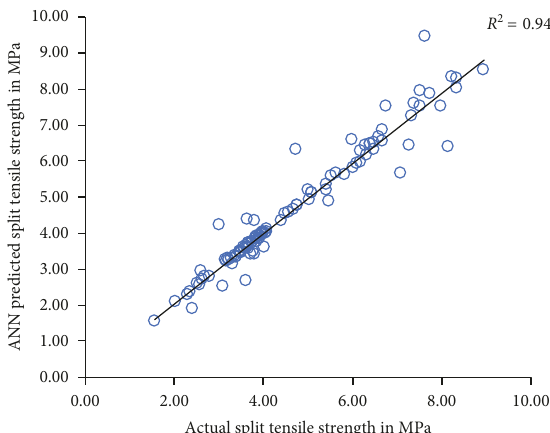
Table 3: Statistical test conducted on prediction models. Predicted parameters